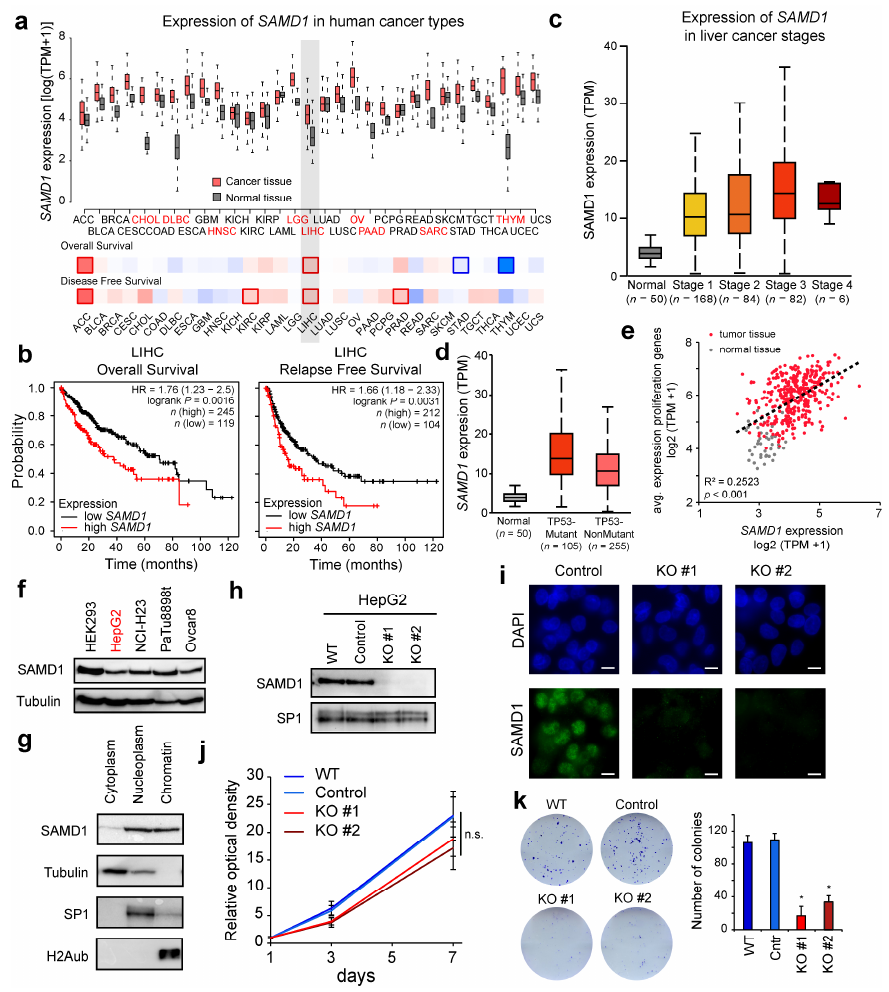
Figure 1. SAMD1 is highly expressed in liver cancer and is associated with poor prognosis, and its deletion impairs the cellular properties of HepG2 cells. ( a ) Comparison of SAMD1 expression in normal and cancer tissue using data from TCGA, visualized by GePIA [35]. Red cancer names indicate significant upregulation. The lower boxes indicate the hazard ratio of patients’ overall and disease-free survival. Red = high SAMD1 expression correlated with poor prognosis. Blue = high SAMD1 expression correlated with good prognosis. Bold frames indicate significance. ( b ) Kaplan– Meier survival curves show the correlation of SAMD1 expression with patient survival. Plots were made using KM plotter [37]. ( c ) Expression of SAMD1 in distinct liver cancer stages derived from UALCAN [38]. Whisker plots represent the upper and lower quartiles with 5 and 95% whiskers. ( d ) SAMD1 expression in patient samples with and without TP53 mutations compared to healthy liver tissue (“Normal”). Data derived from UALCAN [38]. Box plots represent upper and lower quartiles of the data with 5 and 95% whiskers. ( e ) Correlation of SAMD1 expression with the average expression of 11 proliferation-associated genes in liver tissues. The p -value was calculated using ANOVA. ( f ) Western blot of SAMD1 in various human cell lines. HEK293—human embryonic kidney, HepG2—liver cancer, NCI-H23—lung cancer, PaTu8988t—pancreatic cancer, Ovcar8—ovarian carcinoma. The used cell line in this study (HepG2) is marked red. ( g ) Cellular fractionation of HepG2 cells followed by Western blotting. ( h ) Western blot of two SAMD1 knockout clones. ( i ) SAMD1 immunofluorescence in control and SAMD1 KO cells. Bar = 10 µ M. ( j ) Proliferation of wild-type, control, and SAMD1 KO HepG2 cells. Error bars indicate the SD of three biological replicates. ( k ) Representative picture of colony formation of wild-type, control, and SAMD1 KO HepG2 cells and quantification. Error bars indicate the SD of three biological replicates. * p < 0.05 (Student’s t -test). In ( h – k ) “#” refers to two distinct SAMD1 KO